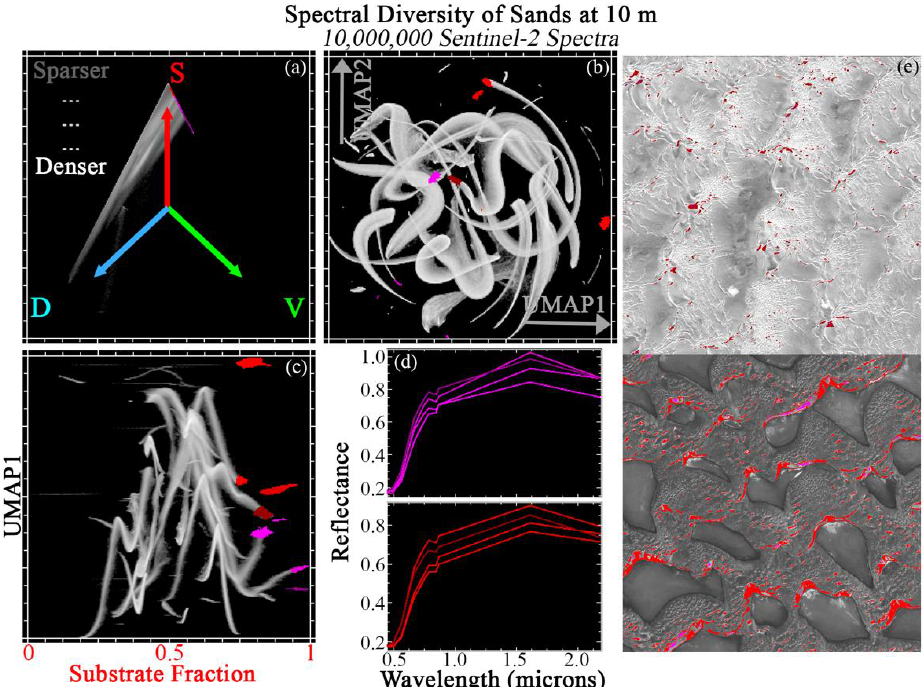
Figure 5. Joint characterization of sands. 10 × 1 megapixel Sentinel-2 tile subsets are selected from global sand hotspots and analyzed at full 10 m pixel resolution. These spectra preferentially occupy the S apex of the SVD mixing space, with mixing toward D ( a ), leaving the V portion of the space very sparse. The global 3-endmember linear mixture model fits these spectra better than the agricultural spectra (here, only >99.9% of spectra with <5% RMSE) — but fractions regularly exceed 100%. UMAP ( b ) captures both subtle mixing continua and discrete clusters, but does not offer physical interpretability. Joint characterization ( c ) uses the physical meaning of the substrate mixture fraction to contextualize the subtle statistical relationships captured by UMAP. Example regions of interest are identified from the joint space and projected onto the ternary mixing and UMAP spaces. Mean spectra for each region ( d ) illustrate similarities and differences among statistically distinct clusters. Clusters identified by joint characterization also frequently show geographic coherence ( e ).